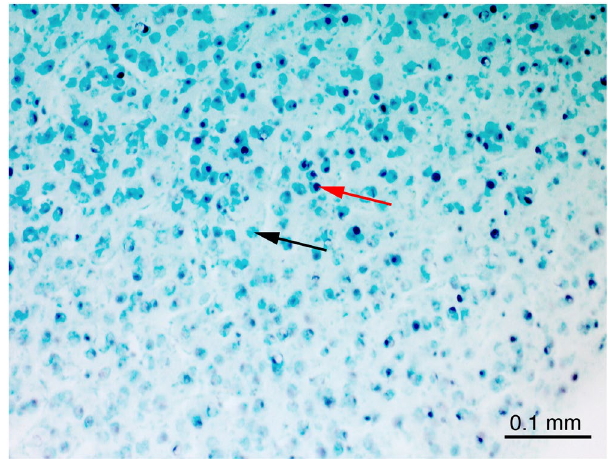
Figure 2. An example of a coronal section showing the region of the nucleus taeniae of the amygdala (TnA) of an experimental chick. c-Fos-positive cells are stained black after the immunohistochemical procedure (red arrow) and are easily distinguishable from the c-Fos-negative cells (black arrow), which were counter stained with